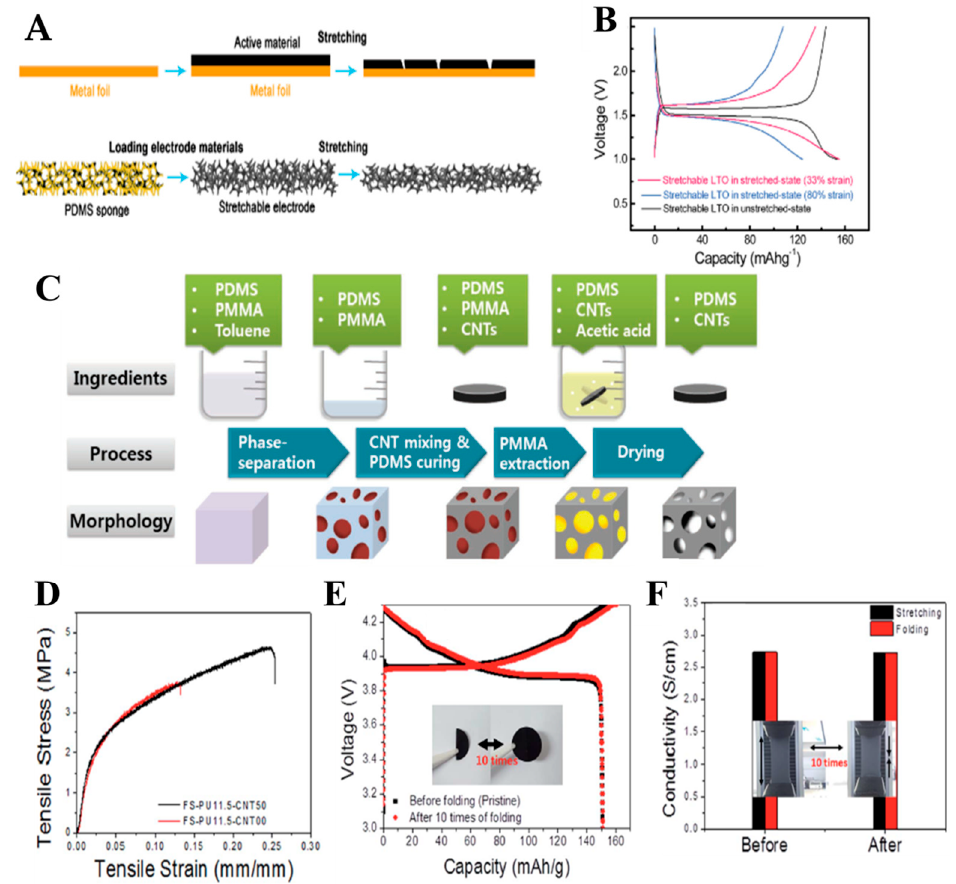
Figure 5. Electrochemical performance and stretchability of the stretchable electrodes. ( A ) Schematic illustration for the comparison of the conventional electrode using metal foil and the stretchable electrode based on the PDMS sponge. Charge / discharge voltage profiles of the stretchable. ( B ) Comparison of charge / discharge voltage profiles between the stretchable LTO anode in unstretched state and stretched states with various strains. Adapted with permission from [68]. Copyright (2016) WILEY-VCH Verlag GmbH and Co. KGaA, Weinheim. ( C ) The procedure to fabricate the porous PDMS–CNT nanocomposites. Adapted with permission from [6]. Copyright (2012) WILEY-VCH Verlag GmbH and Co. KGaA, Weinheim. ( D ) Stress–strain curves of FS-PU11.5-CNT50 and FS-PU11.5-CNT00. ( E ) Charge / discharge capacity after 10 rounds of folding / unfolding and ( F ) electronic conductivity after 10 rounds of folding / unfolding or stretching. Adapted with permission from [76]. Copyright (2017) The Royal Society of Chemistry .